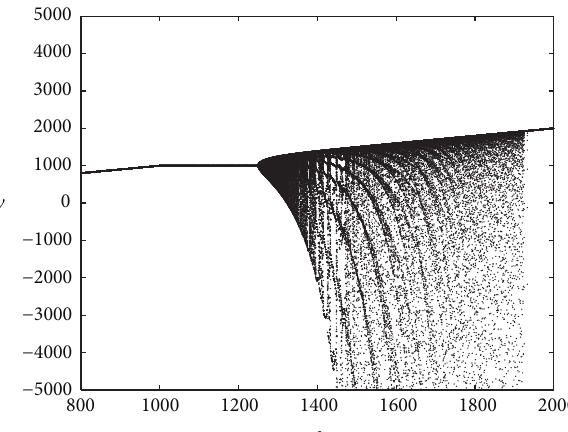
Figure 7: Diagram of bifurcation of the equilibrium points with respect to 𝑦 , for the parameter 𝑠 varying from 800 to 2000, 𝑥 1 = 0.1 , 𝑦 1 = 𝑠 for 𝐴 = 1 , 𝑇 = 1000 , 𝛼 = 0.5 , and 𝑘 = 4 .